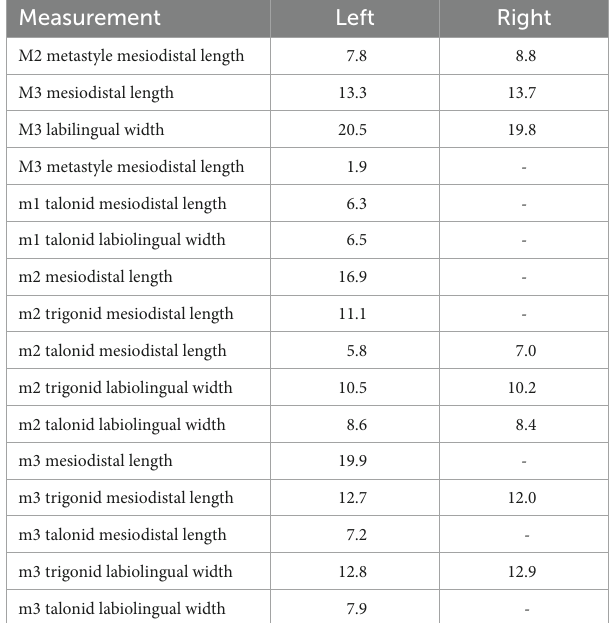
TABLE 1 Dental measurements of SYSU-M-5, the holotype of Maocyon peregrinus , gen. et sp. nov.